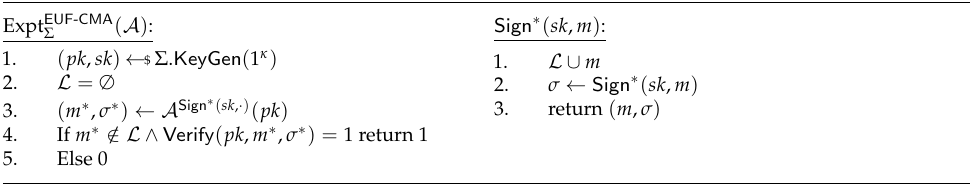
Figure 1. The EUF - CMA security experiments for DSAs.